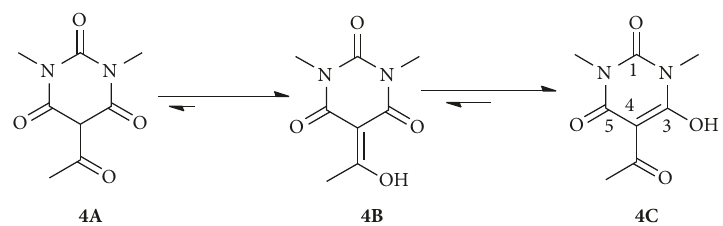
Figure 2: Enol-keto form for the acylpyrimidine derivatives.